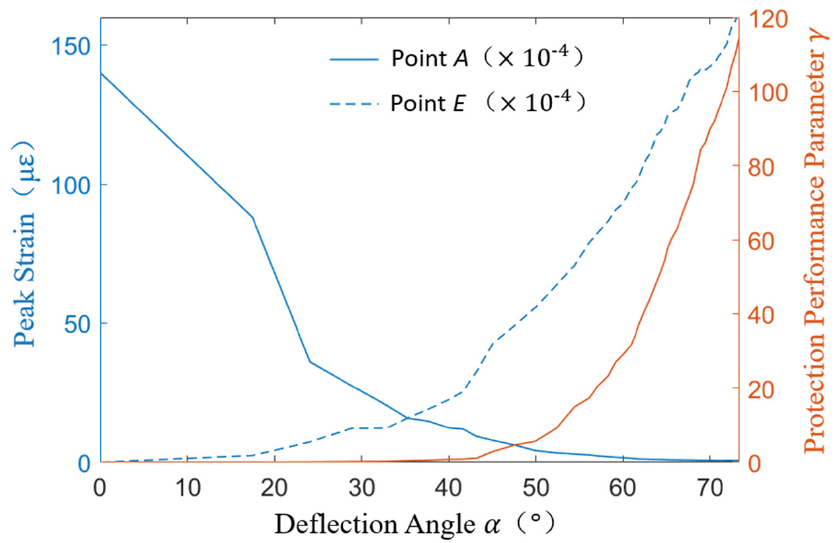
Figure 15. The relationship between the deflection angle of the energy-flow vector and protection performance parameters.